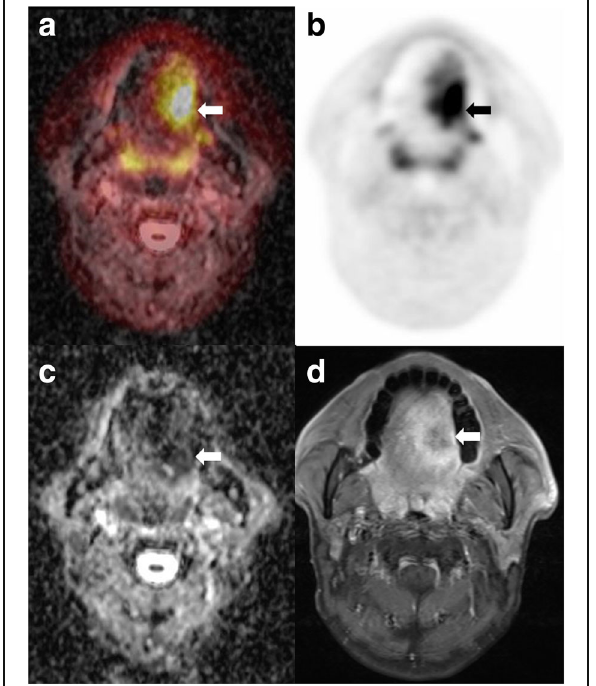
Fig. 3 Case of tongue cancer treatment failure prediction by both MTV and combined PET/MRI parameters. A 50-year-old male underwent preoperative simultaneous 18 F-FDG PET/MRI due to a 3.8-cm-sized left tongue cancer. a Fusion image of regional PET with ADC map and b regional PET images showed left tongue mass with hypermetabolism (arrows). c ADC map image demonstrated left tongue mass with diffusion restriction (arrow). d Gadolinium-enhanced T1 axial image revealed mass with peripheral enhancement (arrow). SUVmax (9.73), MTV (35.02), TLG (135.18), ADCmean (424.15), (SUVmax/ADCmean)×1000 (10.37), (MTV/ADCmean)×1000 (82.57), and (TLG/ADCmean)×1000 (318.70) predicted tumor treatment failure. The patient showed tumor treatment failure in pleura, multiple bones, and lymph nodes 6 months after tongue cancer surgery